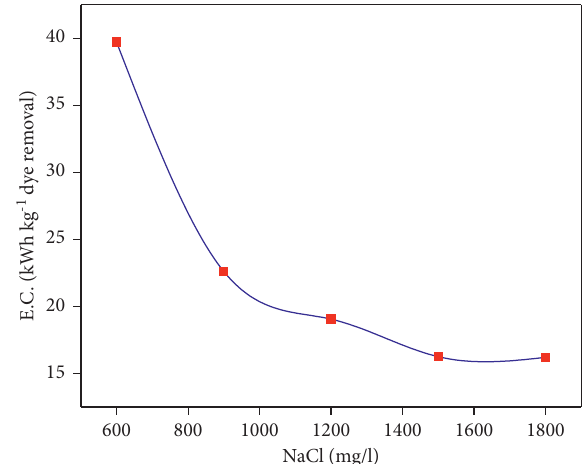
Figure 7: Effect of electrolytic concentration on energy con- sumption (CD 5.31 mAcm − 2 and EC time